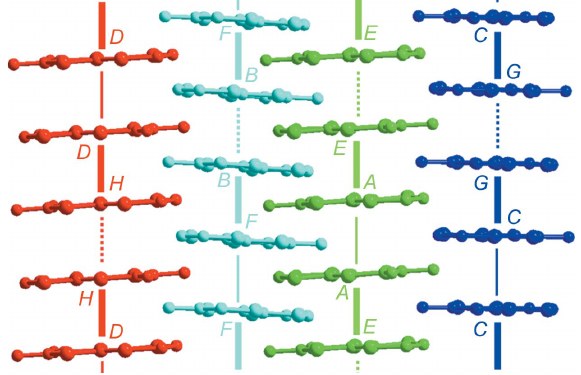
Figure 8 Views of the four tetramerized stacks with AE , BF , CG and DH dimers in the 20 K structure of ( o -Me 2 TTF) 2 NO 3